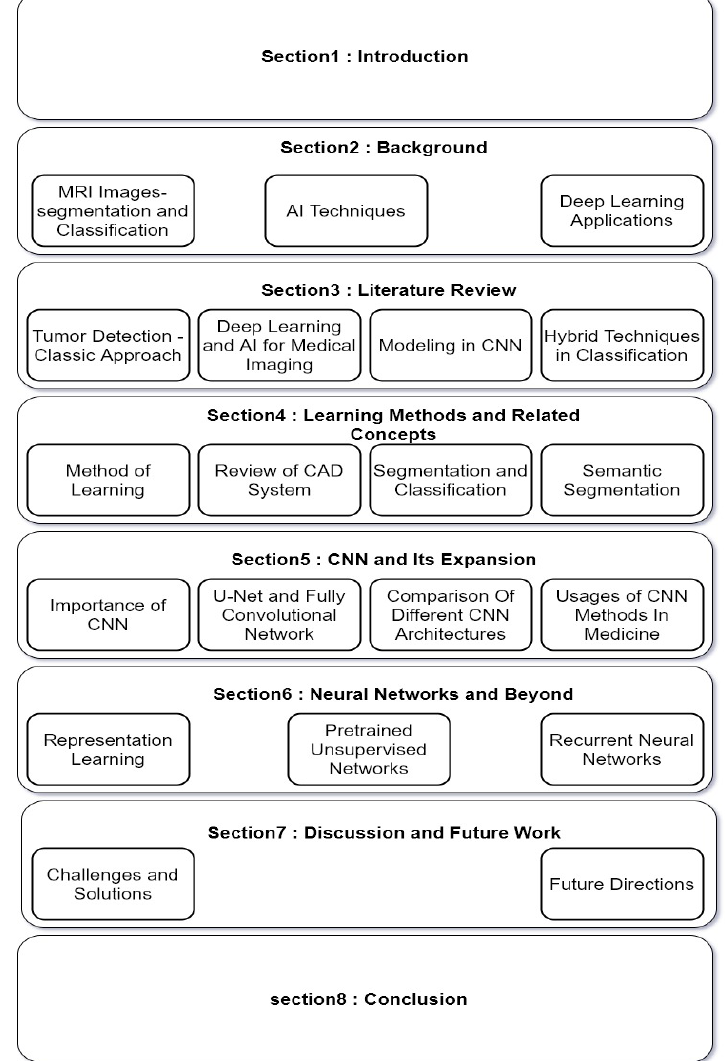
Figure 1. The structure of this